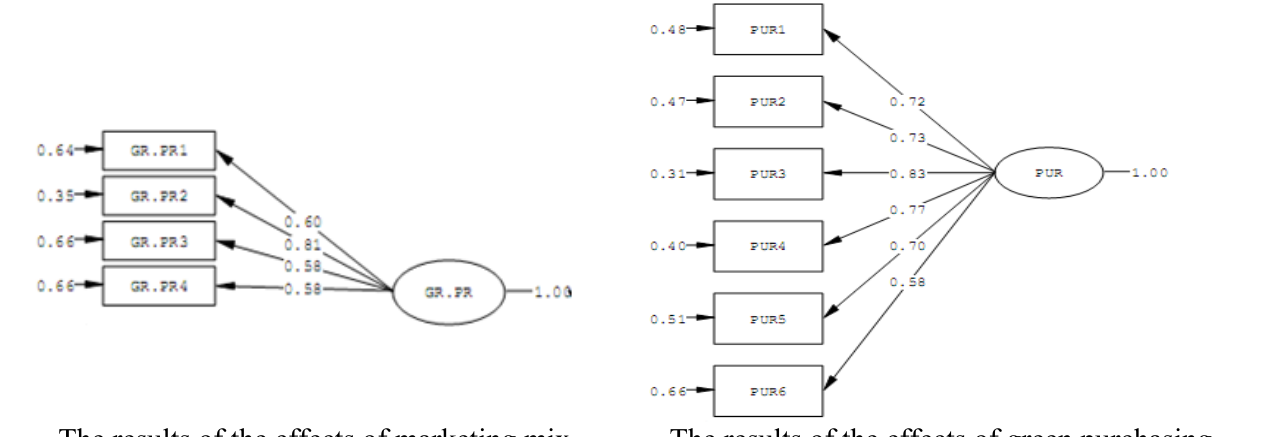
Fig. 2. The effects of standard values for marketing mix and green purchasing